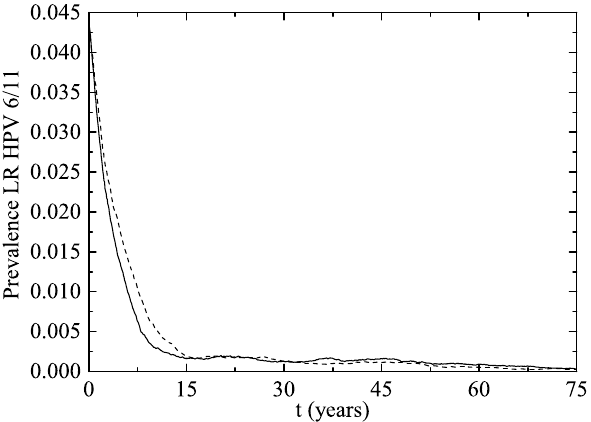
Figure 2. Percentage of women aged 14–26 infected of LR HPV 6 and/or 11 after the implementation of the vaccination program (Scenario 1: solid line and Scenario 2: dotted line).